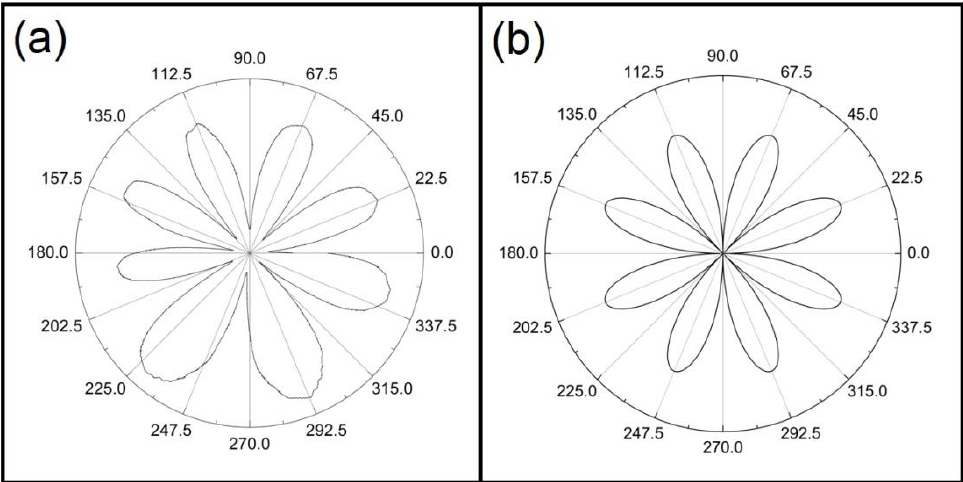
Figure 10. Intensity plots for linear polarization when applying a sextupolar magnetic field to the ferrofluid. In ( a ) we have the graph obtained from the experiment with the luminous pattern of Figure 9b in the region demarcated with the circumference made with the green dashed line. In ( b ) we have the intensity graph obtained with the Stokes vector of Equation (15).